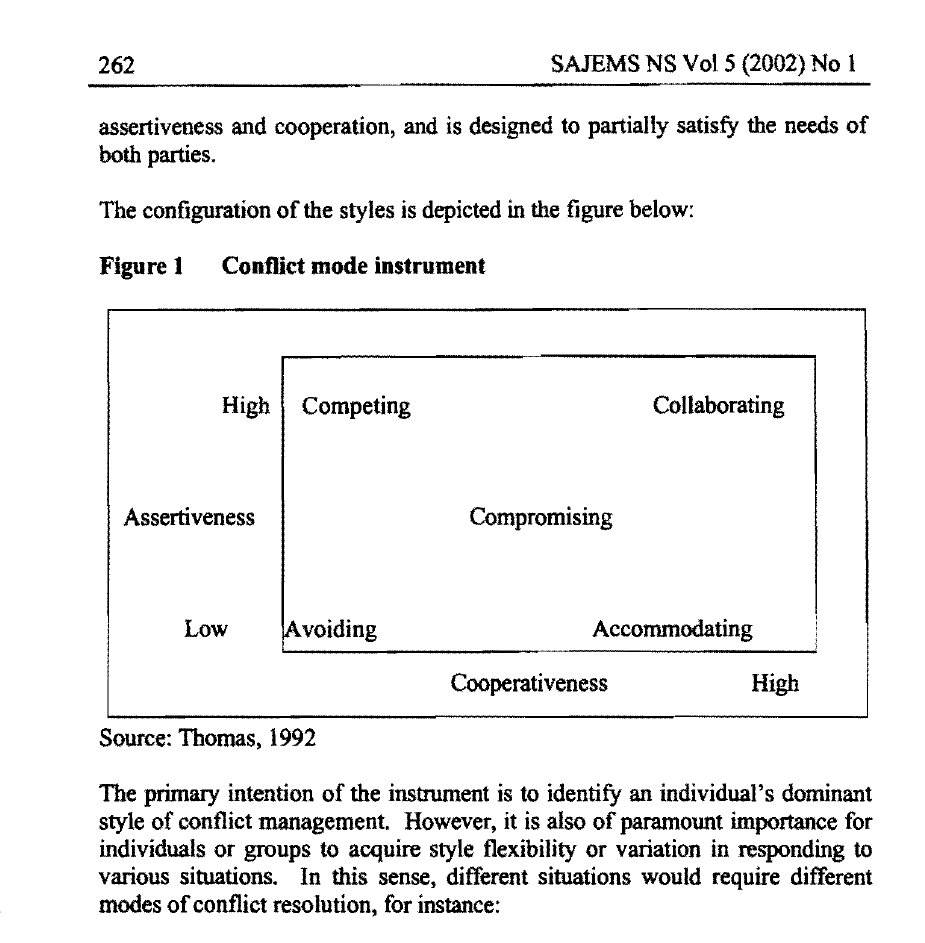
Low !Avoiding Accommodating Cooperativeness